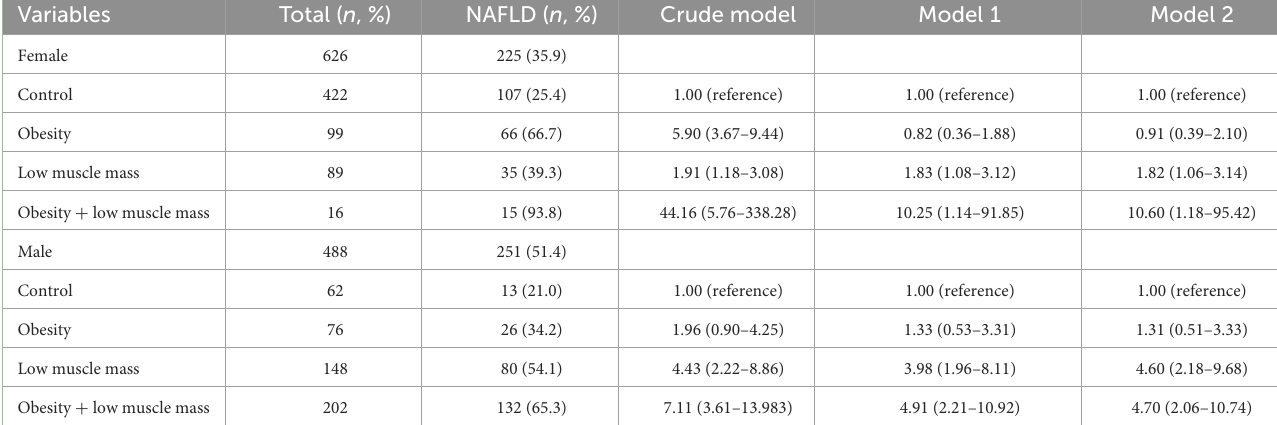
TABLE 3 Gender-specific association between obesity, low muscle mass and obesity with low muscle mass on risk of NAFLD by